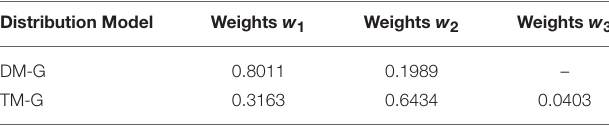
TABLE 4 | Weight value of mixed probability density distribution of Xichang data on July 20, 2018. Distribution Model